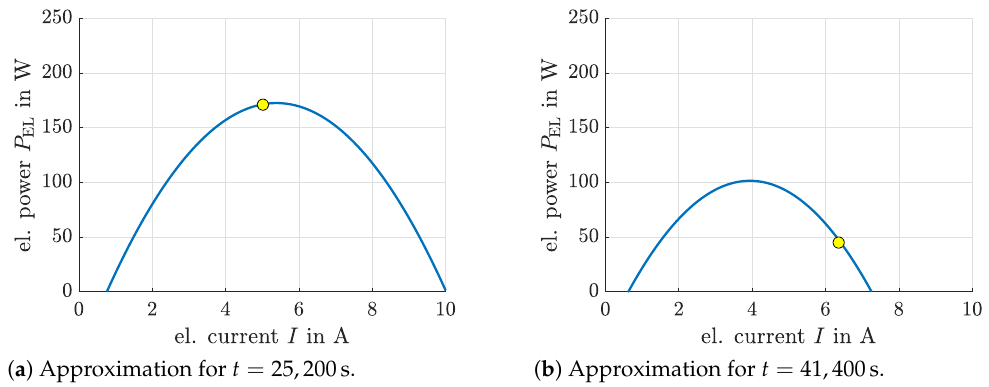
Figure 12. Estimated quadratic approximations of the power characteristics as a function of the electric current I for operating points not exceeding the maximum power point (Figure 12a) and exceeding this critical point (Figure